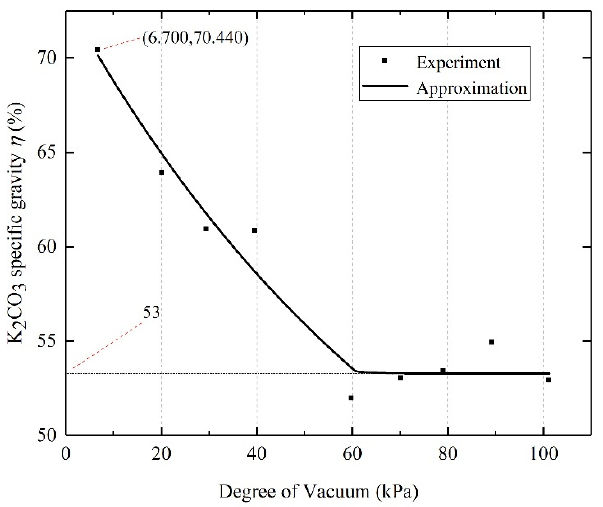
Figure 4. K 2 CO 3 specific gravity change diagram with vacuum degree.